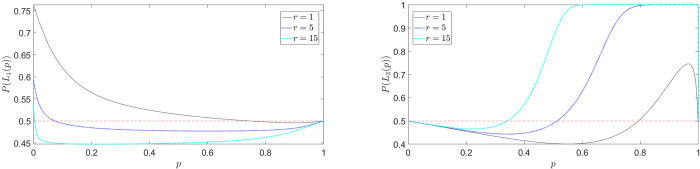
Fourfold pattern of risk attitudes: Choice probabilities as a function of outcome probabilities (Eq (15)).(a) P(L1(p)) for task (A); (b) P(L3(p)) for task (B). In this example we set D = 10 and scan different values of the CARA coefficient r.